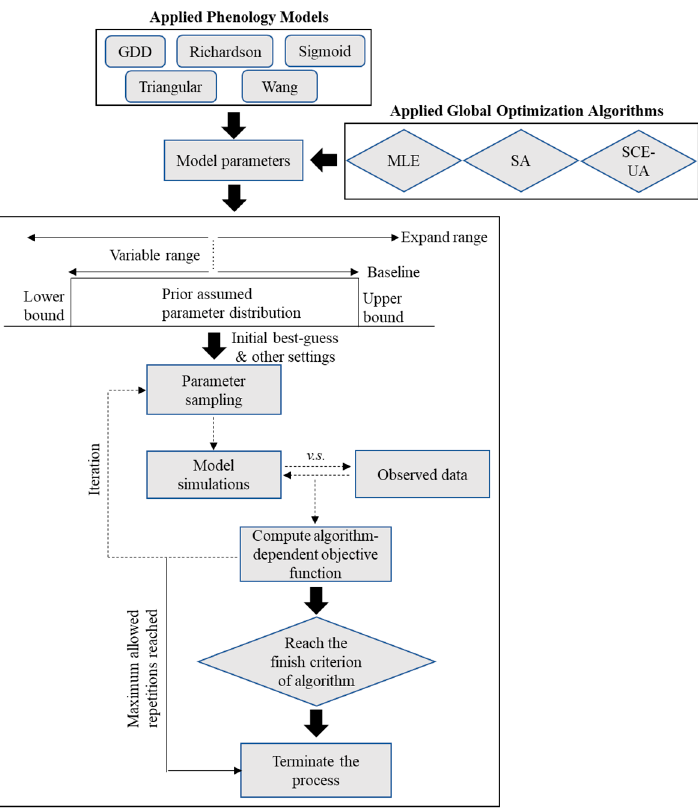
Figure 2. A universal procedure to apply different optimization algorithms in order to estimate the parameters of phenology models. The iterative process is denoted by dash lines.